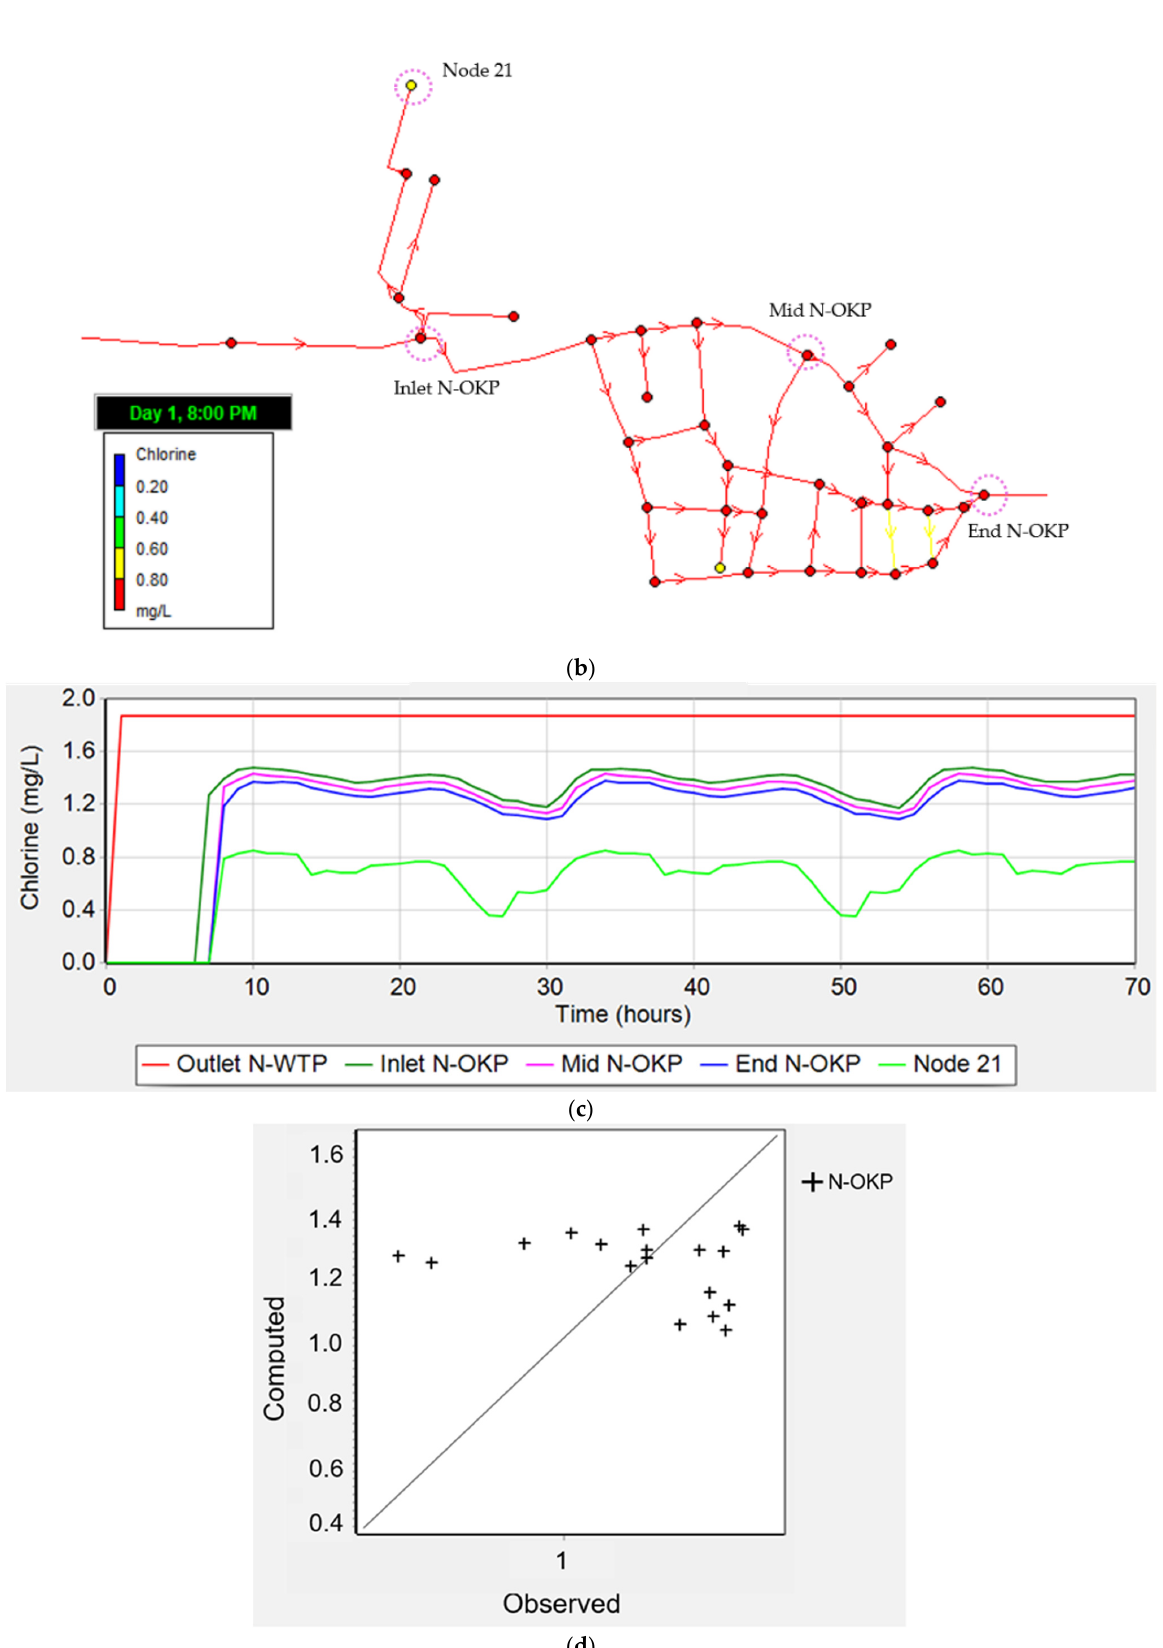
Figure 4. Simulation of chlorine in Phase 2 (N-WTP outlet: 1.9 mg/L): ( a ) network model, ( b ) residual chlorine in N-OKP, ( c ) time course of chlorine concentration, and ( d ) observed vs. simulated